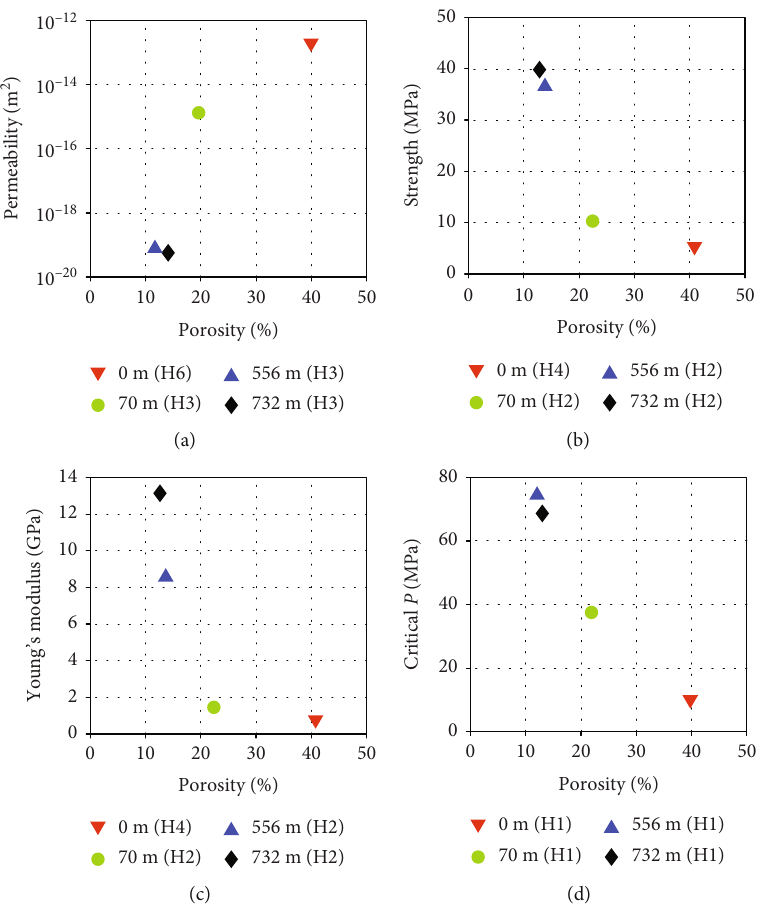
Figure 8: Physical and mechanical attributes of hyaloclastites from di ff erent depths within the hydrothermal reservoir at Kra fl a volcano, NE Iceland. (a) Permeability (at an e ff ective pressure of 4MPa) as a function of porosity showing a nonlinear positive correlation. (b) Strength as a function of porosity showing a nonlinear negative correlation. (c) Young ’ s modulus decreases by an order of magnitude over the range of porosity examined. (d) Critical e ff ective mean stress (critical P ), marking the brittle to ductile transition of each material depends on porosity (note the value for the sample from 556 m is a minimum as critical P was not met up to an e ff ective mean stress of